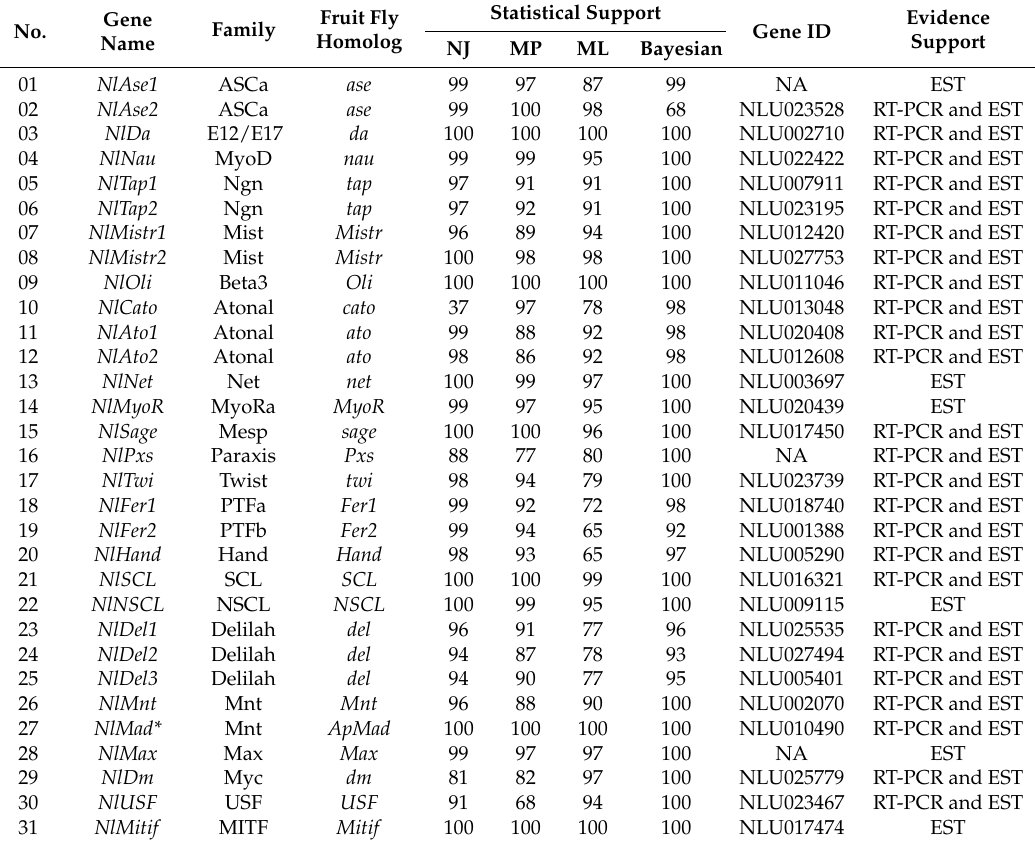
Table 2. A complete list of basic helix-loop-helix ( bHLH) genes from Nilaparvata lugens